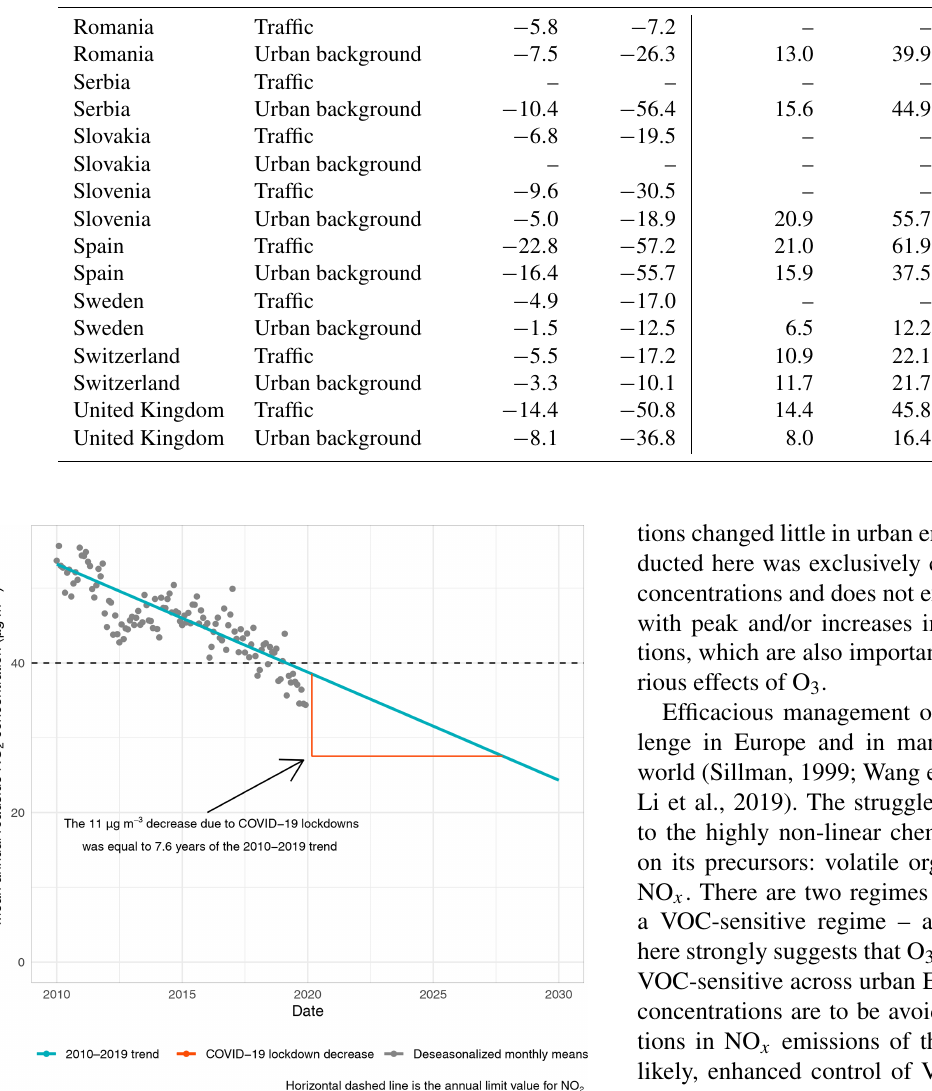
Figure 7. Mean European roadside NO 2 trend with the reduction in NO 2 concentrations attributed to the COVID-19 lockdowns put into